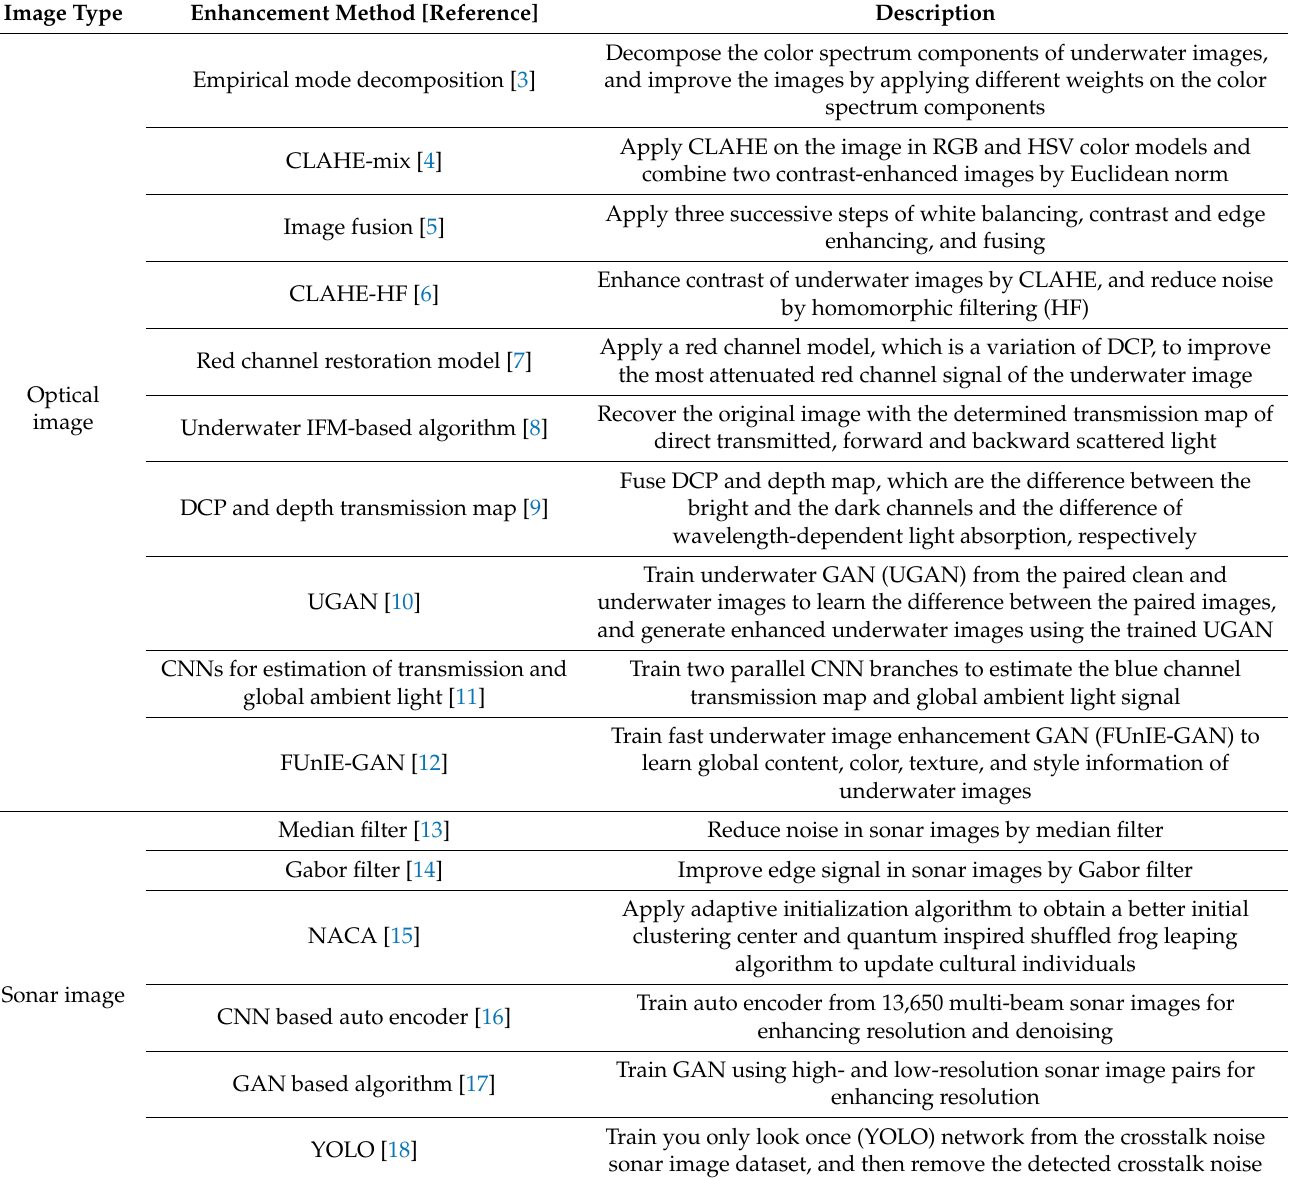
Table 1. Summary of single-image enhancement techniques for optical and multi-beam sonar